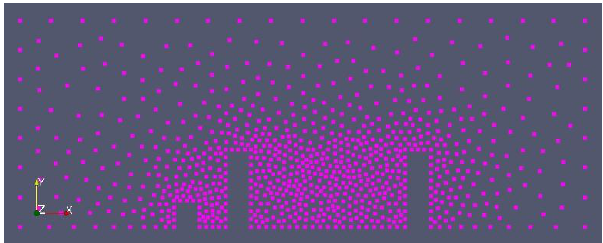
Fig. 14 Number of observations nobs =852.